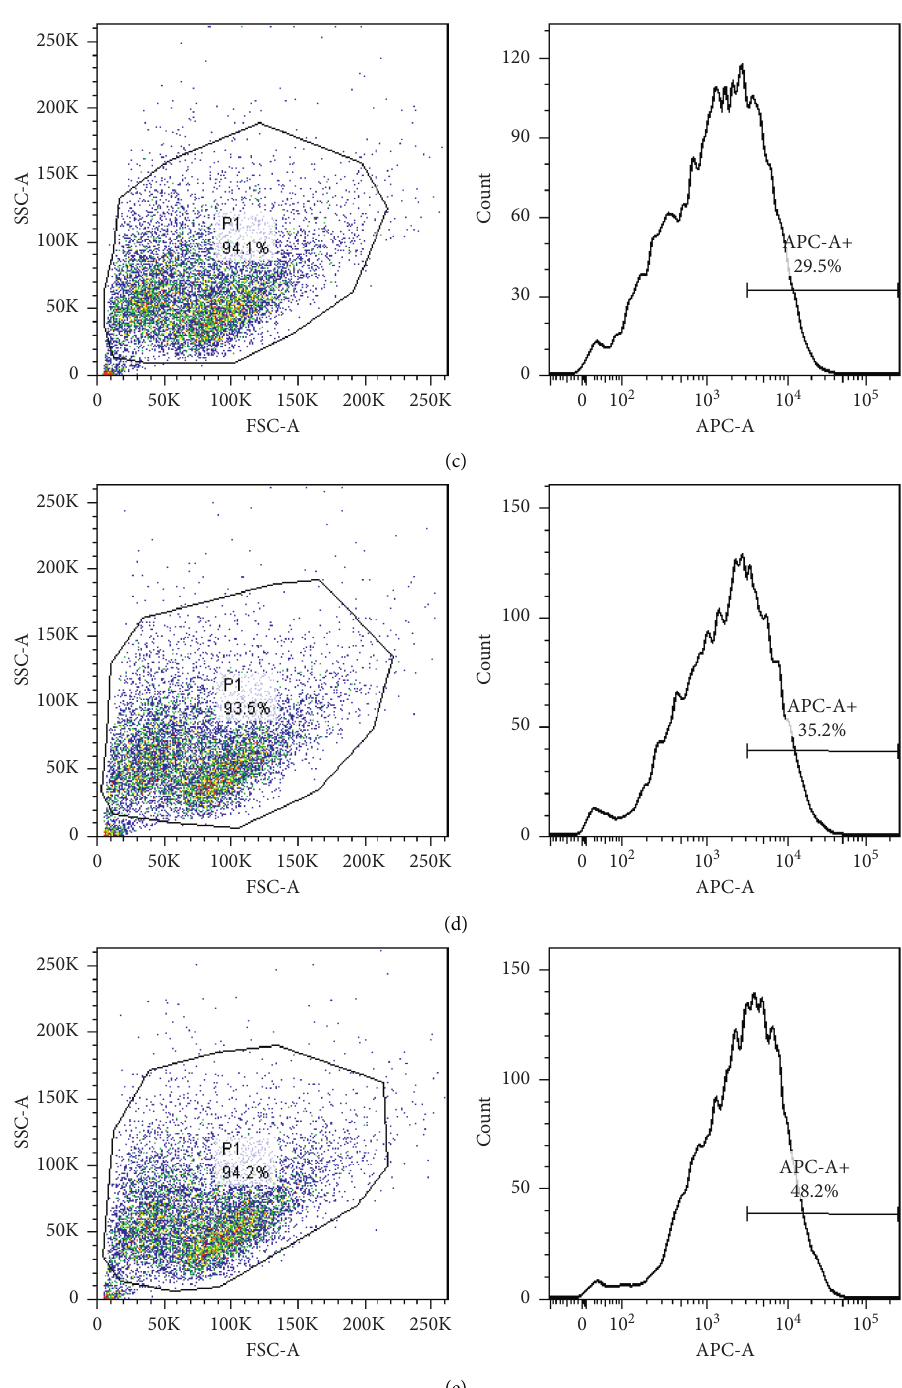
Figure 6: The transfection efficiency of different concentrations of siRNA in TM cells (APC-A+ indicates the number of cells labeled with Cy5). (a) Transfection of 10nM Cy5-NC-siRNA control group. (b) Transfection reagent +10nM Cy5-NC-siRNA group. (c)